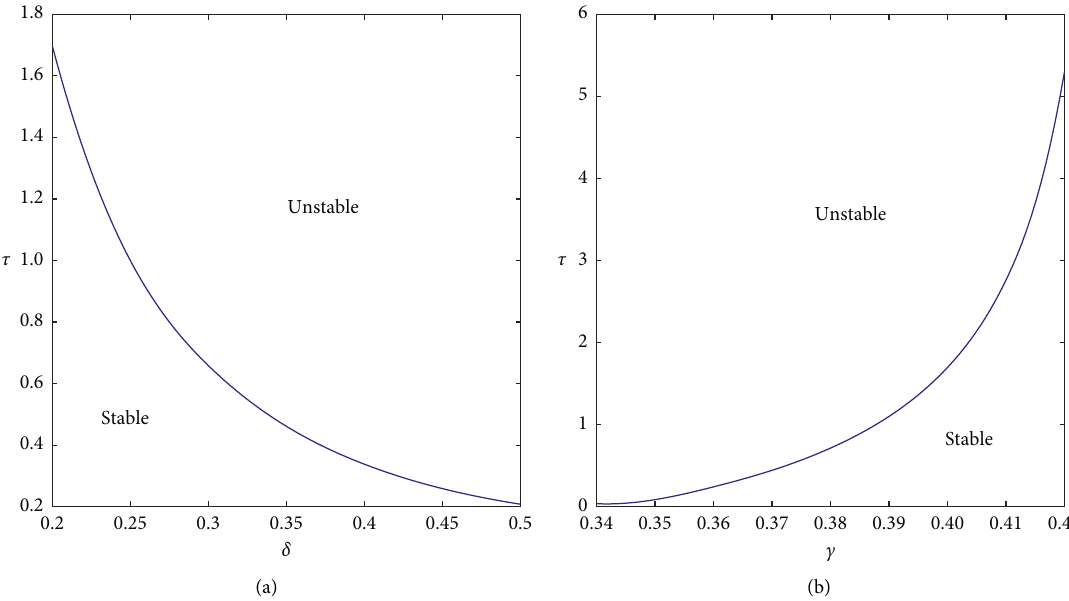
Figure 11: (a) The two-parameter bifurcation diagram of the model (52) with c � 0 . 4, τ ∈ ( 0 . 2 , 1 . 8 ) , and δ ∈ ( 0 . 2 , 0 . 5 ) . (b) The two parameter bifurcation diagram of the model (52) with δ � 0 . 2, τ ∈ ( 0 , 6 ) , and c ∈ ( 0 . 34 , 0 . 42 ) . The blue color line (Hopf bifurcation curve) separates the stable and unstable